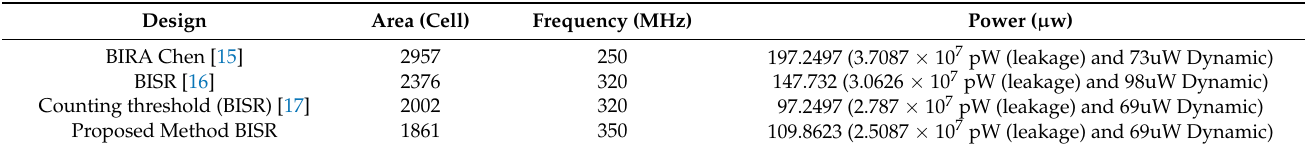
Table 9. Comparison area, timing, and power for the proposed and other BISR approaches.